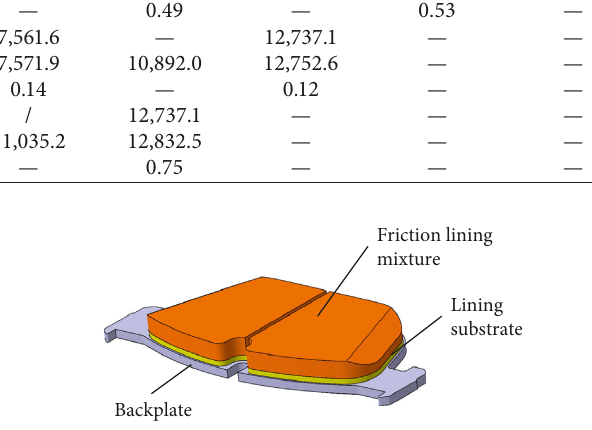
Figure 5: Composition of brake